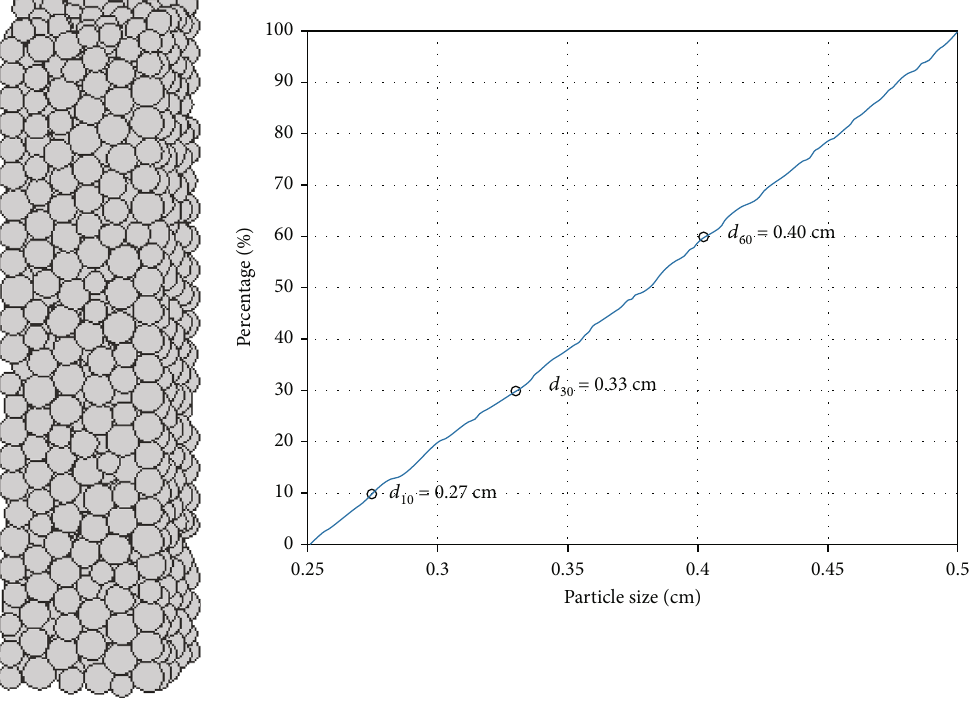
Figure 3: Random generation of sphere and particle size distribution.